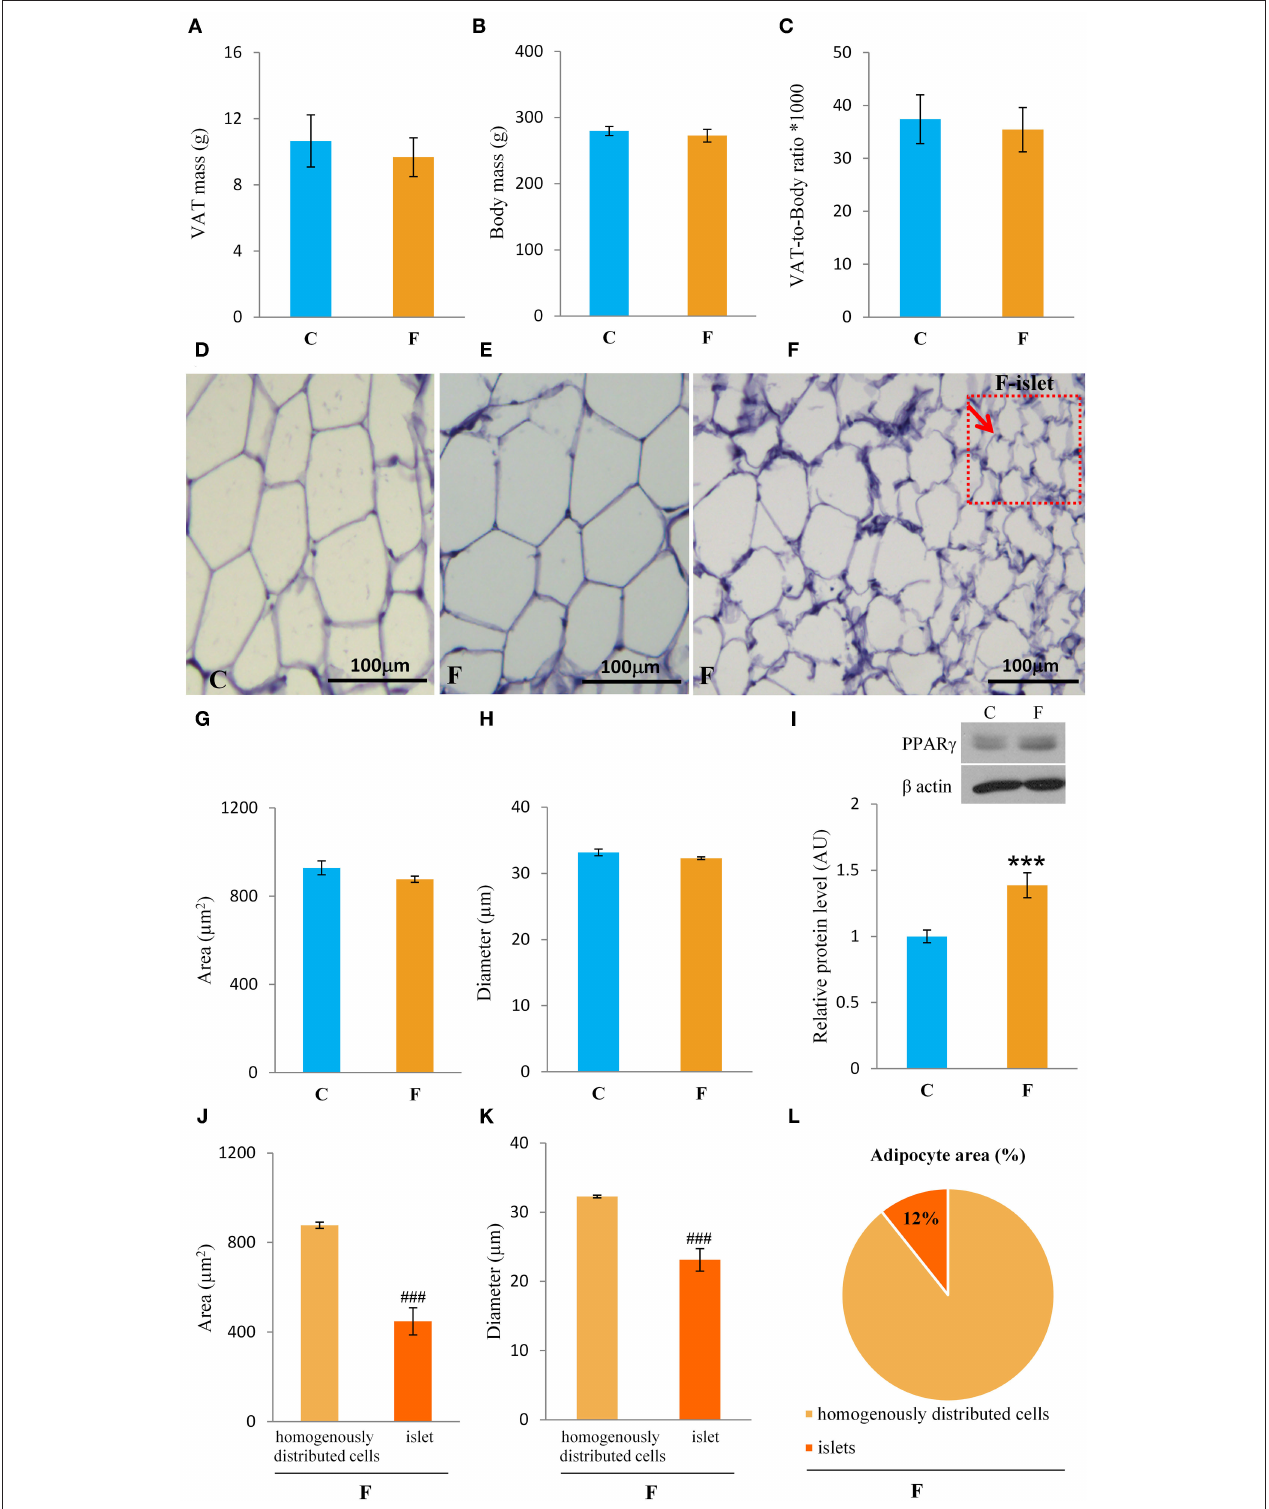
FIGURE 2 | Characterization of visceral adipose tissue (VAT) from female rats fed with 10% fructose diet for 9 weeks. (A) VAT mass, (B) body mass, (C) VAT-to-body ratio, (D) representative histological VAT sections (magnification × 10) stained with hematoxylin and eosin of control, (E) fructose-fed female rats and (F)